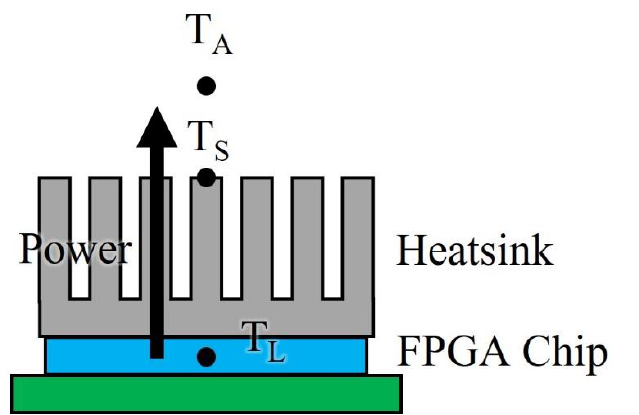
Figure 10. Base cross-sectional view of the simplified thermal flow (FPGA chip comprises FPGA fabric and HBM2).